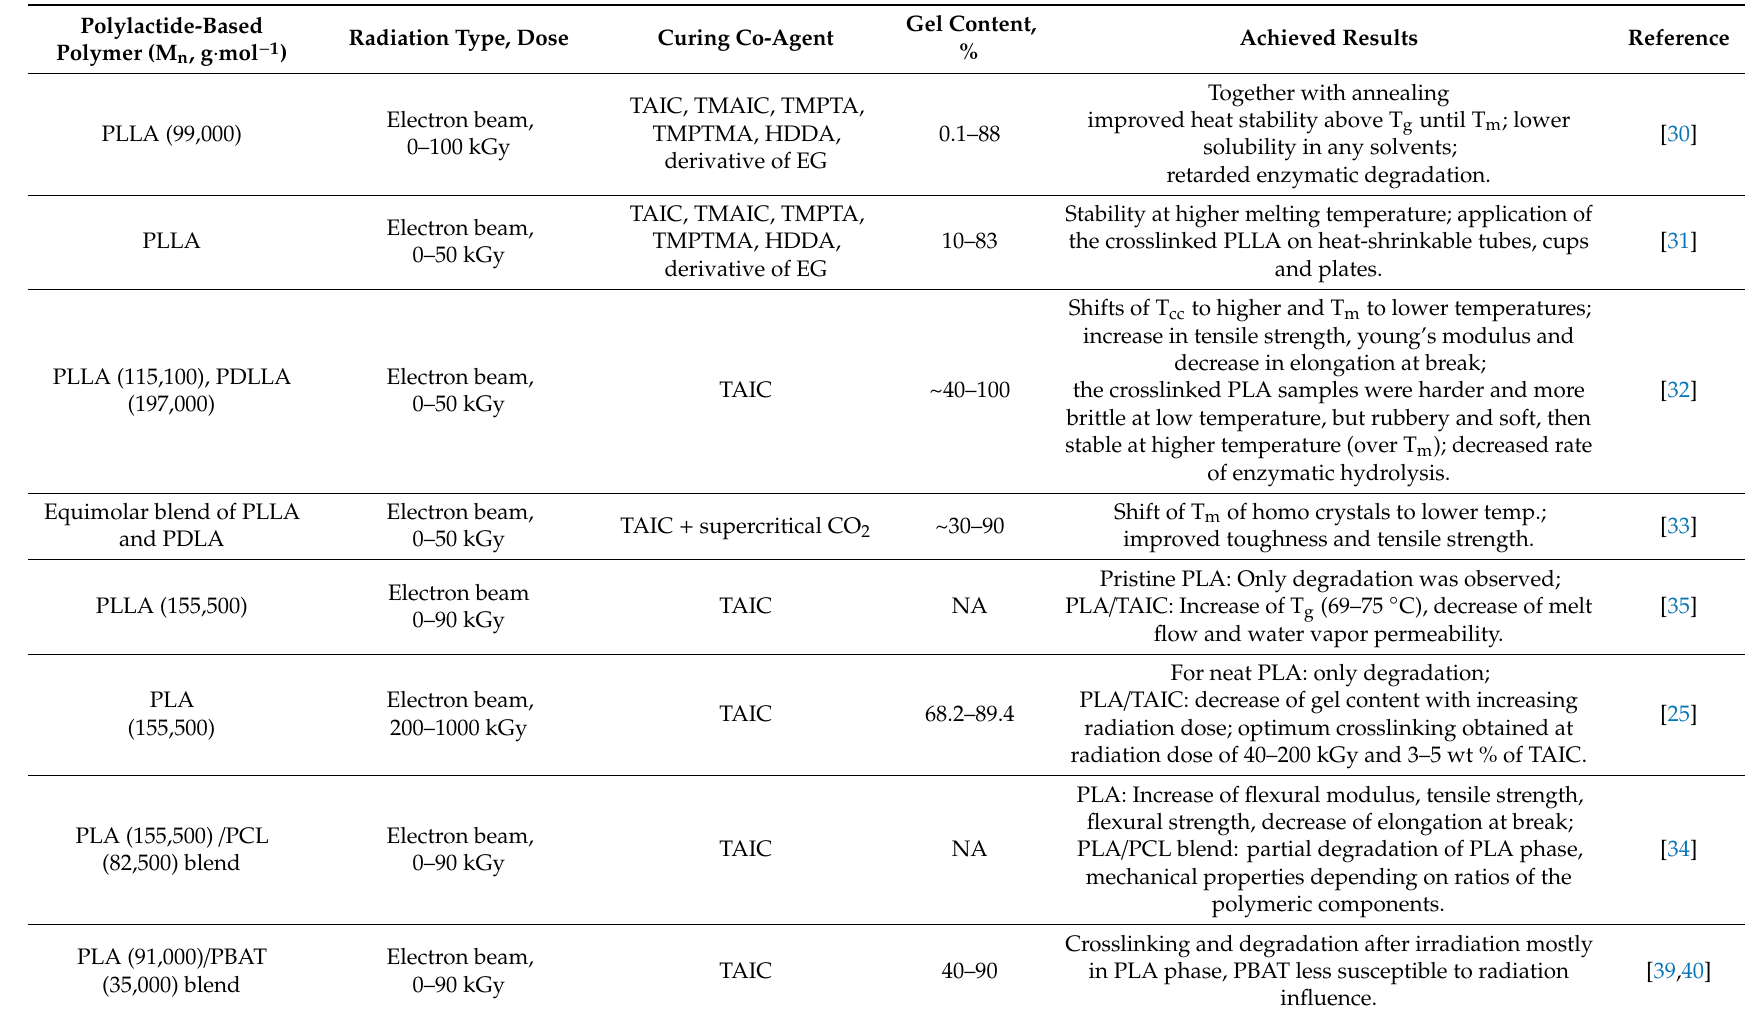
Table 1. Ionizing radiation curing of